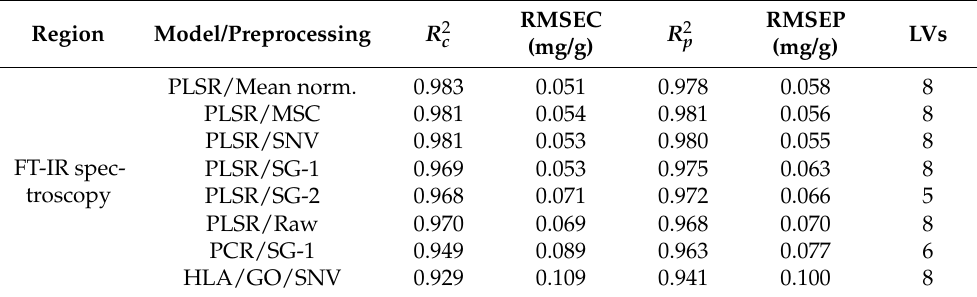
Table 5. Results from the developed PLSR, PCR, and HLA/GO models for the prediction of phenolic compounds in A. thaliana leaf powder samples using FT-IR spectroscopy.